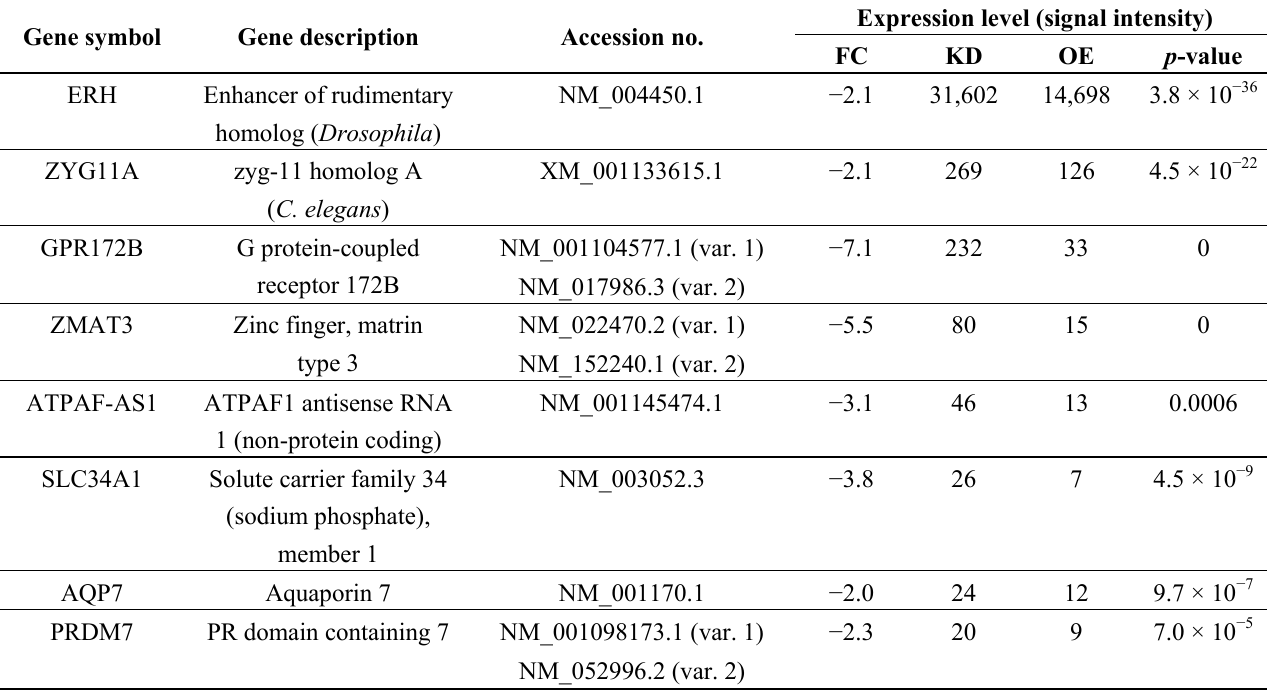
Table 1. Potential candidate genes regulated by